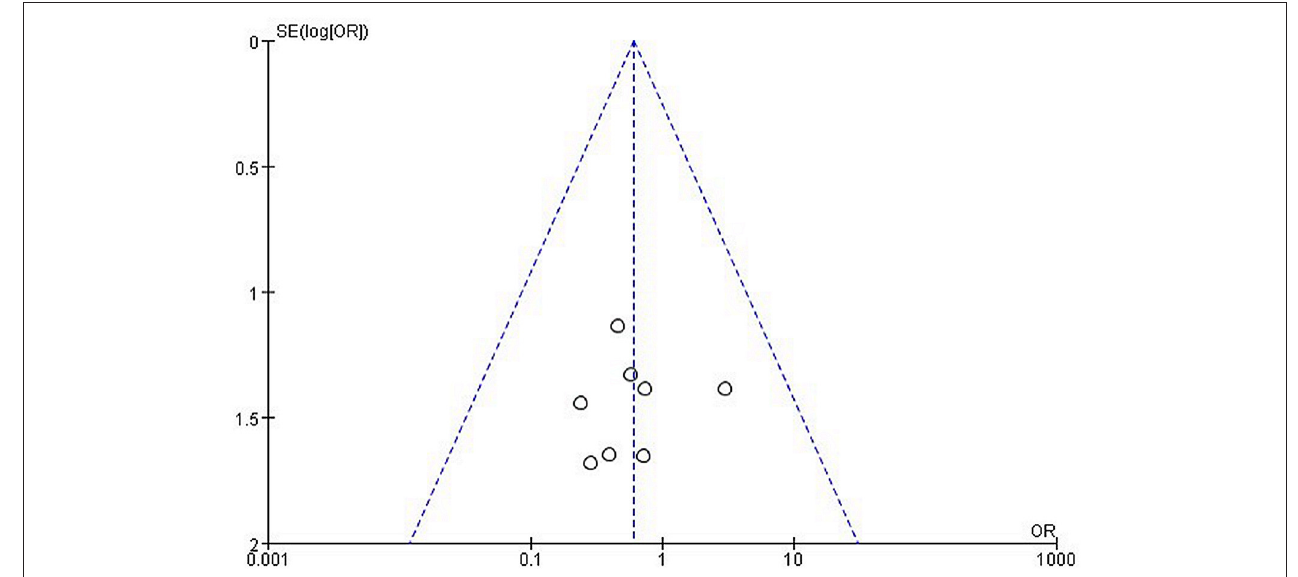
FIGURE 4 | Funnel plot of the